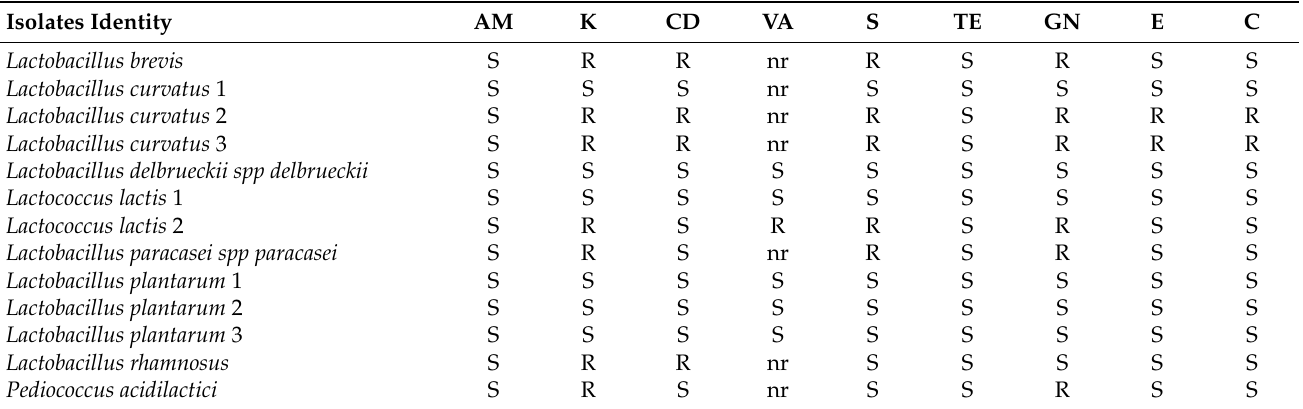
Table 4. Evaluation of sensitivity to